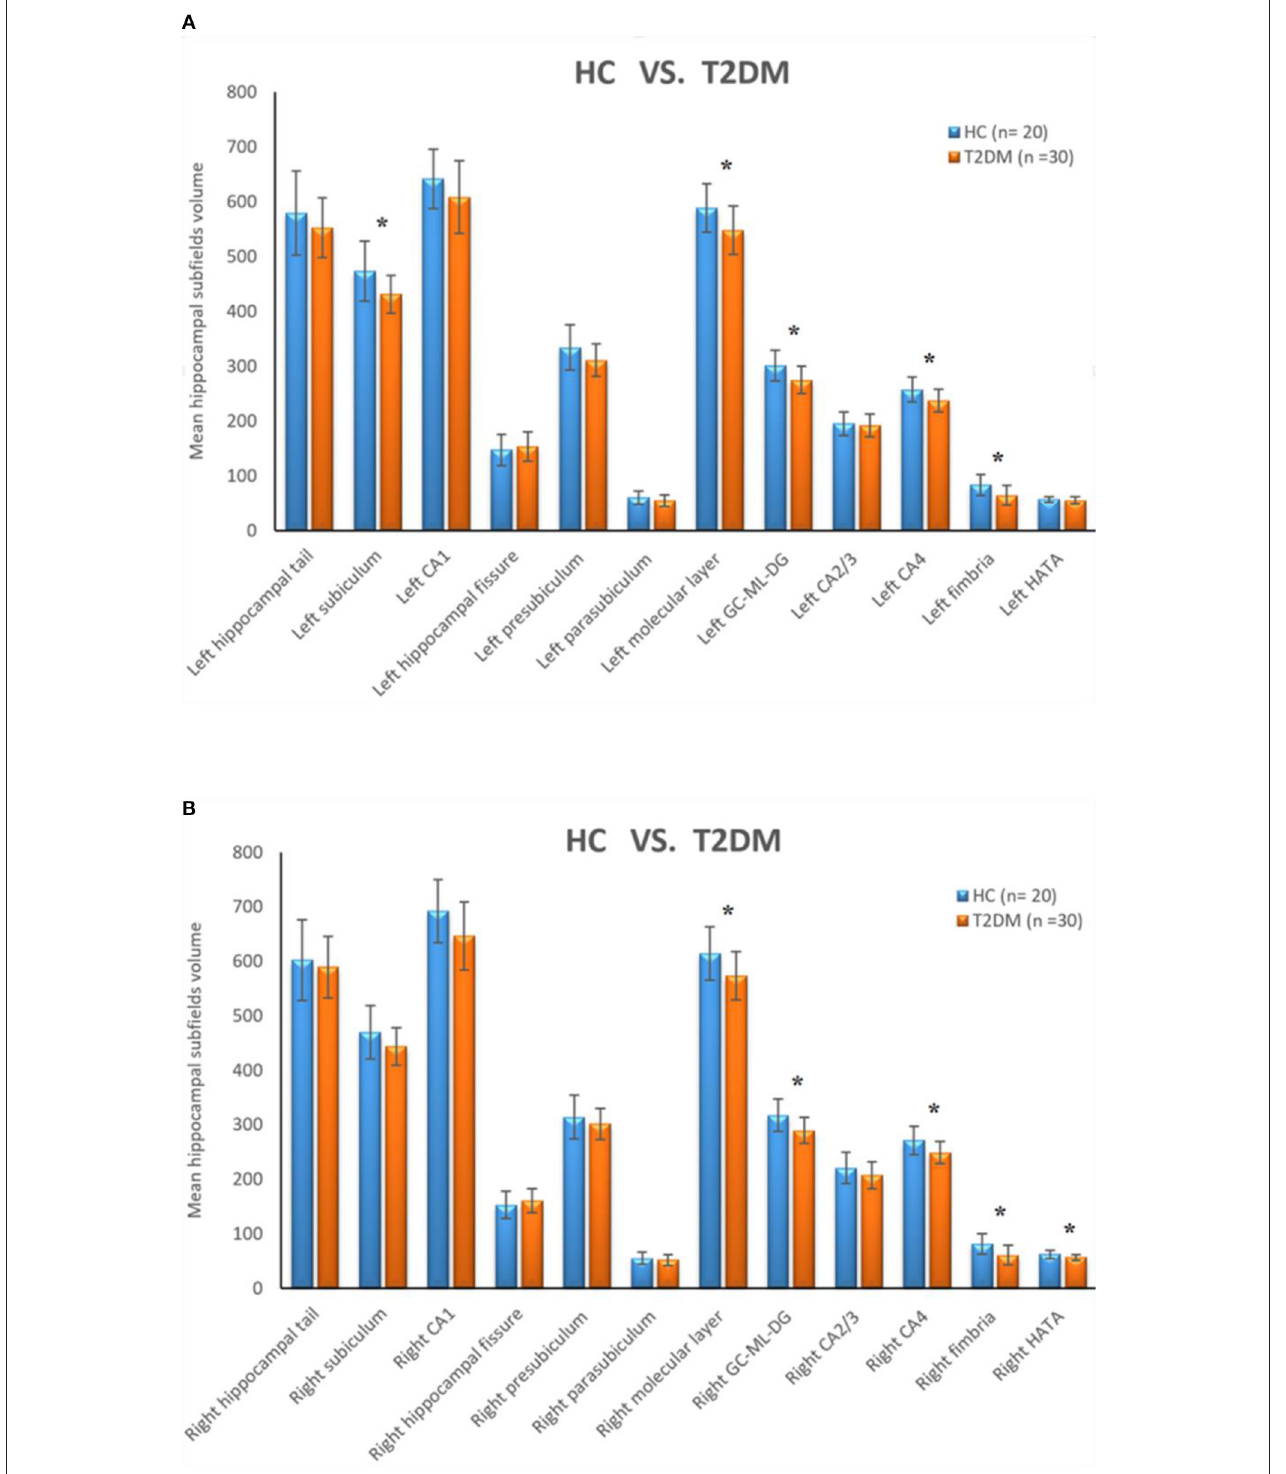
FIGURE 2 | (A) Comparison of the volumes of left hippocampal subfields between HC group and T2DM group. (B) Comparison of the volumes of right hippocampal subfields between HC group and T2DM group. *Correction adjusted P value ( q ) < 0.05.